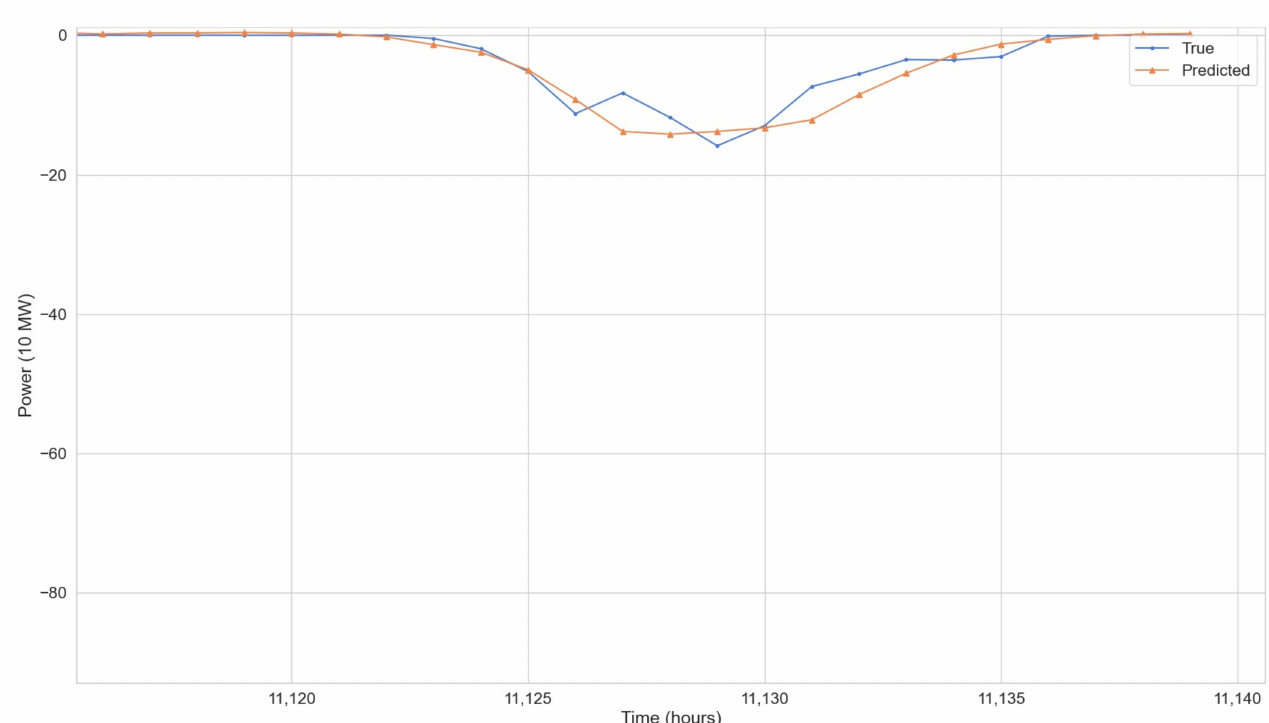
Figure 11. True vs. Predicted PV capacity output for 3 days.